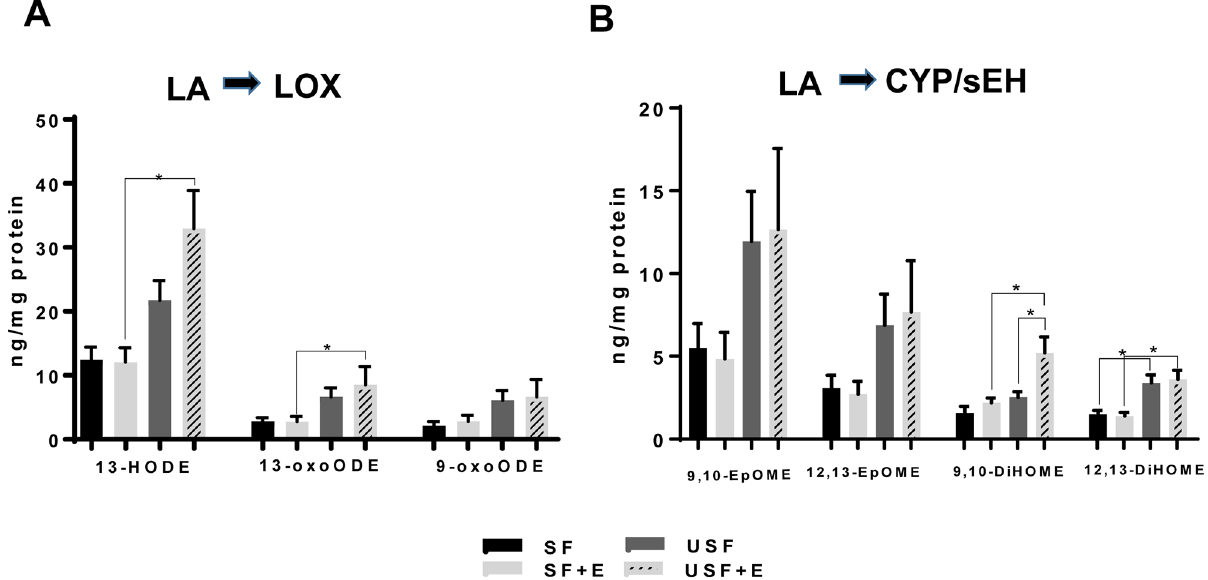
Fig 5. Ethanol-mediated changes in hepatic oxylipins derived from linoleic acid. A: LOX-derived hydroxy-metabolites of LA. B: Changes in epoxy- and dihydroxy-metabolites of LA derived via CYP/sEH pathway. Data are presented as means +SEM, Two way ANOVA, (cid:3) P < 0.05, n = 6 animals per group. CYP, cytochrome-P450 epoxygenase; E, ethanol; LA, linoleic acid; LOX, lipoxygenase; SF, saturated fat; sEH, soluble epoxide hydrolase; USF, unsaturated fat. Individual oxylipin abbreviations in S2 Table.